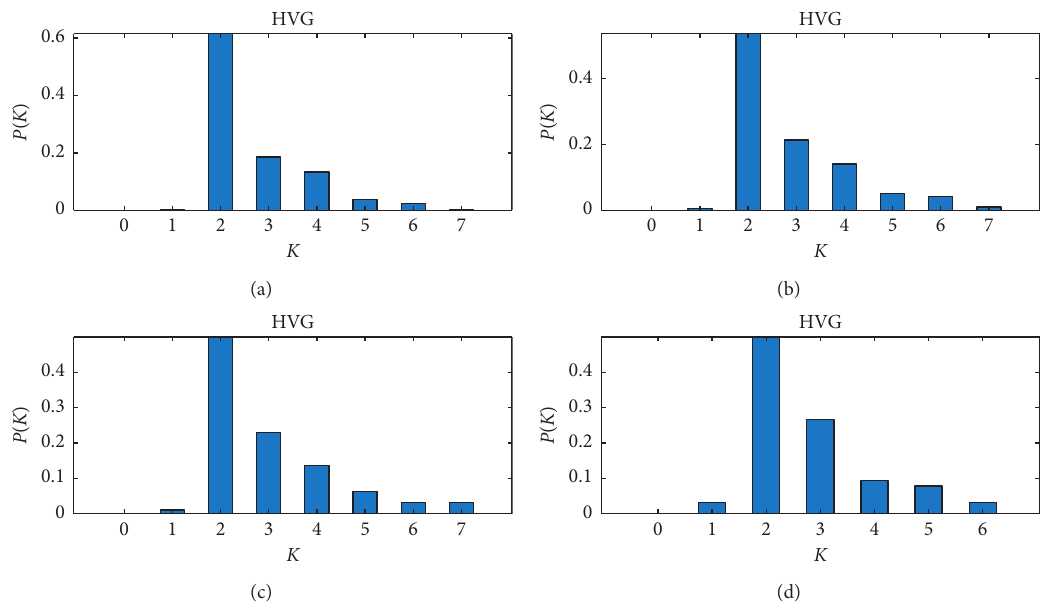
Figure 11: Degree distribution of horizontal visual graph. (a) Δ t � 2min. (b) Δ t � 5min. (c) Δ t � 10min. (d) Δ t �